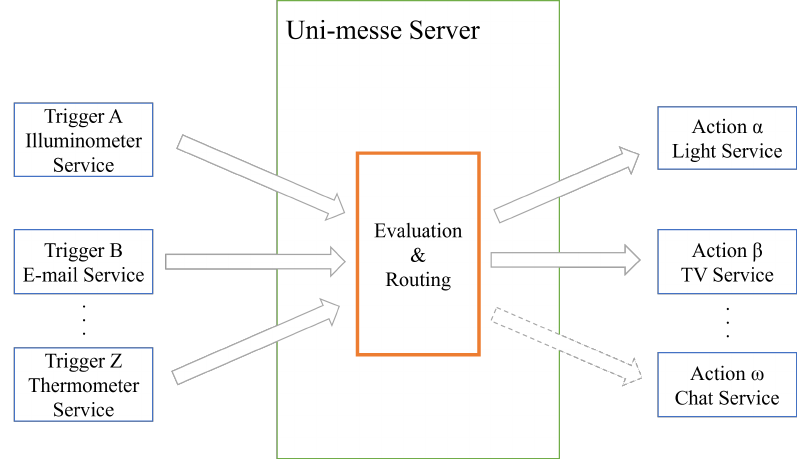
Figure 6. Service connections with